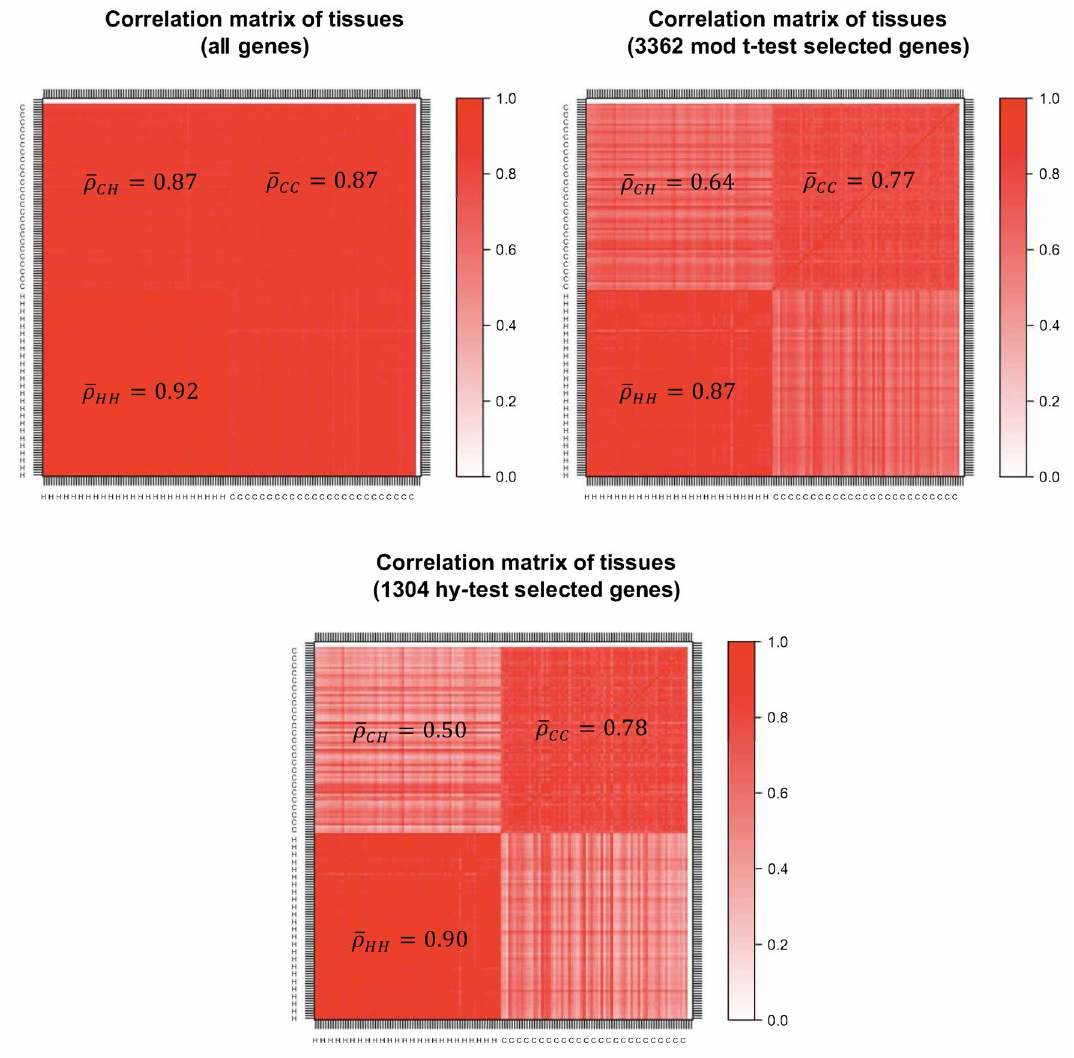
Figure 2. Correlation structure of breast cancer expression genes. Top-left panel refers to all genes, the top- right panel refers to the set of genes selected by moderated t-test, and the bottom panel refers to the set of genes selected by the Hy-test. ¯ ̺ is the block average